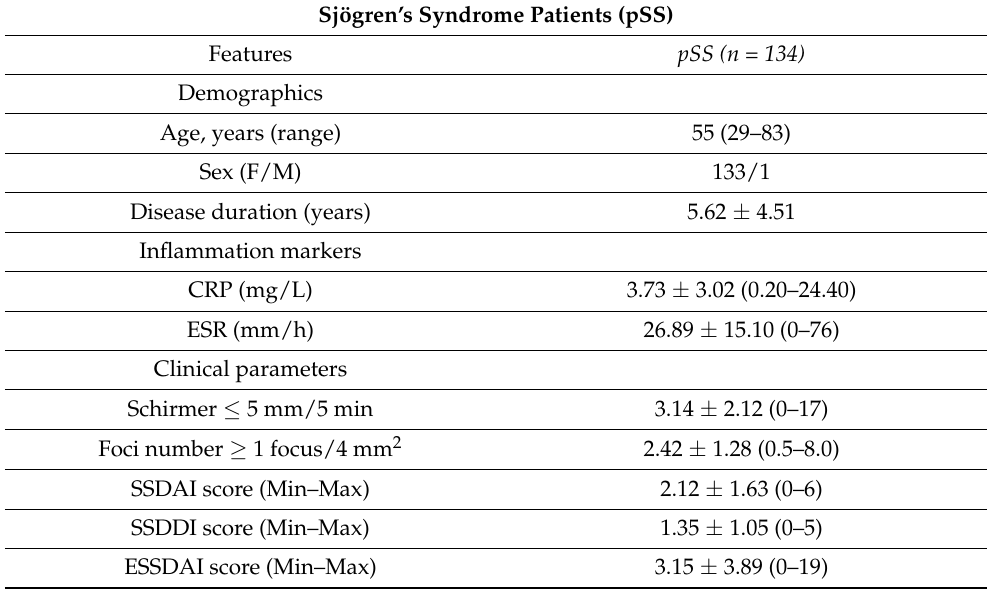
Table 1. Demographic and clinical characteristics in